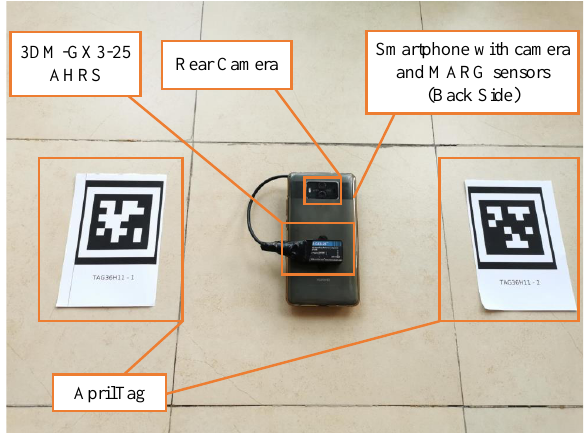
Figure 2. Experiment system for algorithm